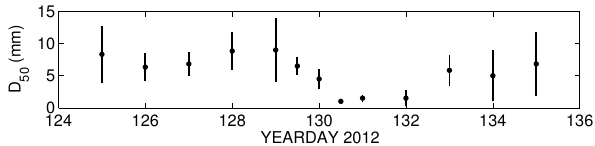
Figure 10. Grain size versus time. The points are the values of D 50 averaged at 6 locations evenly spaced across the shoreface, from 15 m shoreward to 45 m seaward of the frame location. Compare to the forcing and bed roughness time series, Figures 5 and 6. The plotted grain sizes were obtained using the Rubin (2004) method.